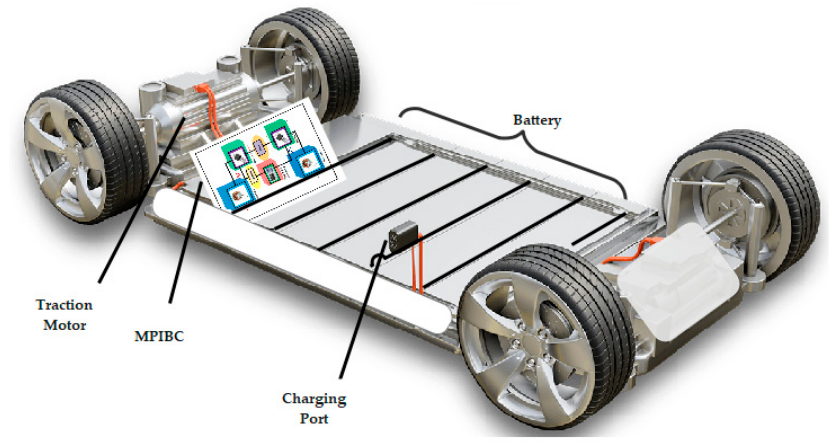
World Electr. Veh. J. 2022 , 13 , x FOR PEER REVIEW Figure 8. MPIBC (Two phase) hardware circuit diagram. Figure 8. MPIBC (Two phase) hardware circuit diagram.